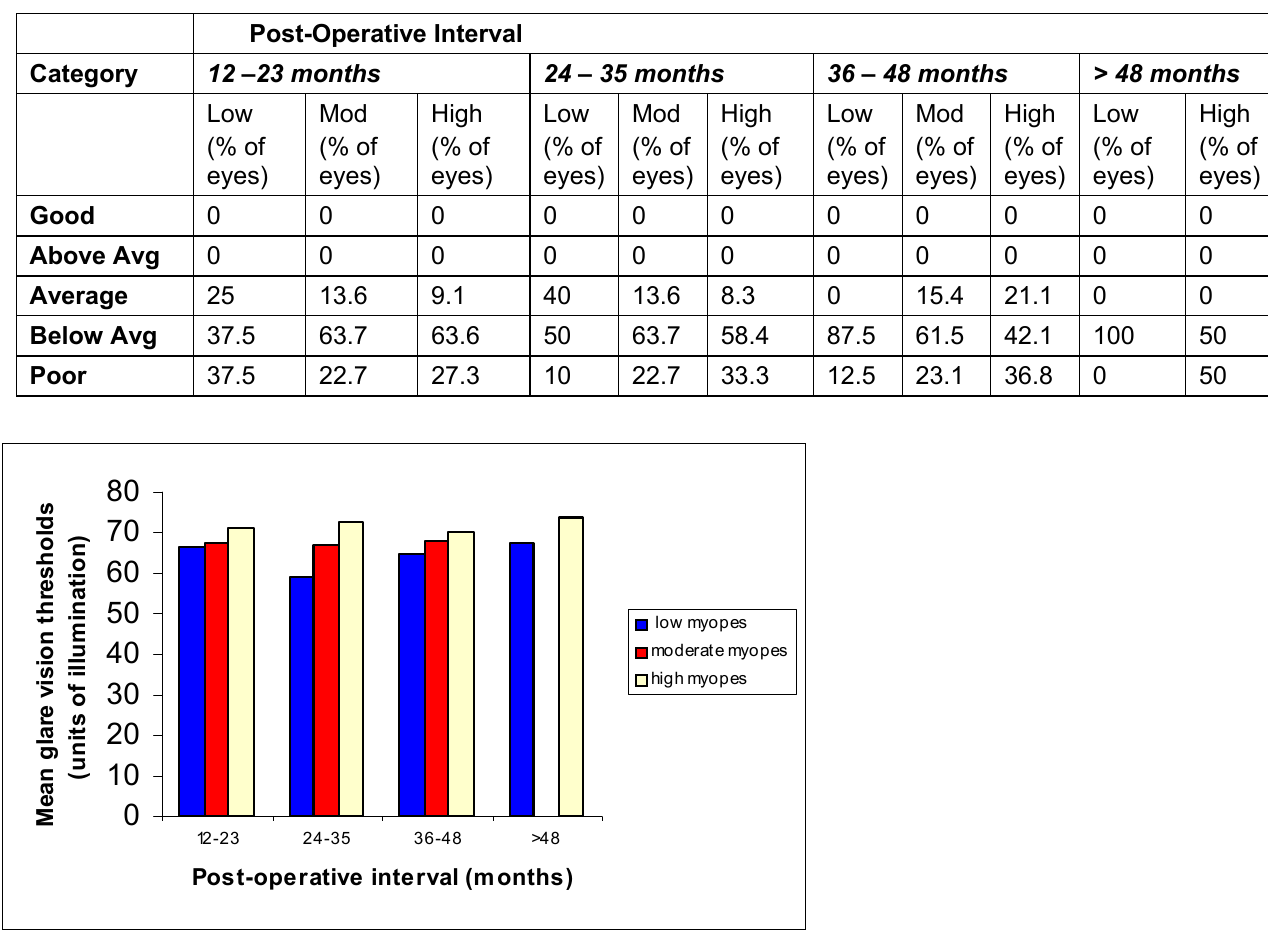
Table 3 .Categorization of glare vision threshold for the different degrees of pre-operative refractive errors in the different post-operative intervals